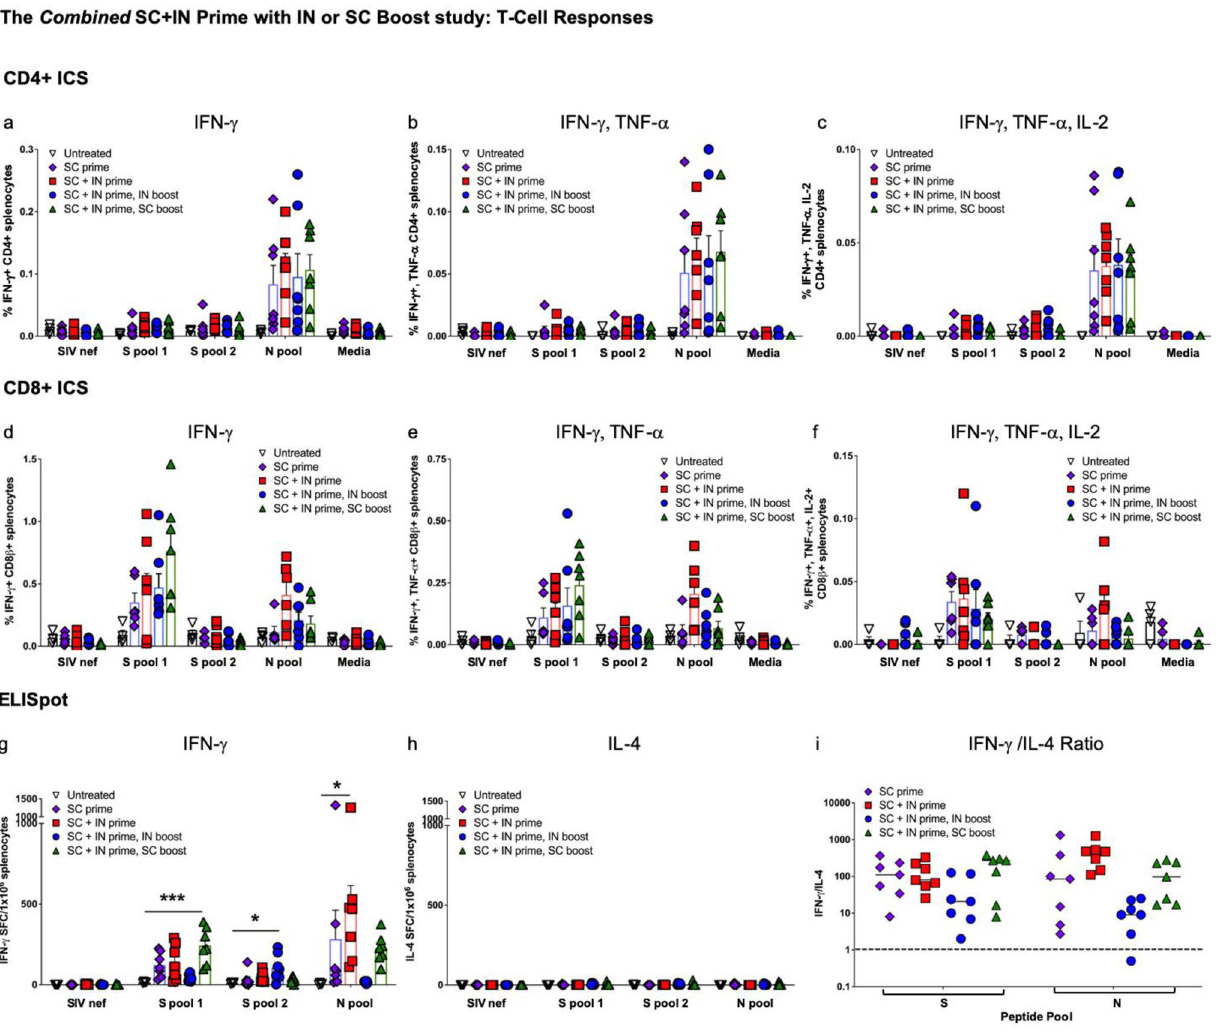
Figure 7. CD4 + T cells respond to nucleocapsid (N) and CD8 + T cells to spike in the combined SC plus IN prime study with SC or IN boost . ICS of IFN-γ; IFN-γ/TNF-α; and IFN-γ/TNF-α/IL-2 in response to S peptide pools 1 and 2 as well as the N peptide pool for CD4 + ( a – c ) and CD8 + ( d – f ) T lymphocytes is shown. Some outliers by the Grubb’s test were removed. SIV nef and media are negative controls. ELISpot for ( g ) IFN-γ and ( h ) interleukin-4 (IL-4) secretion in response to the peptide pools I shown. SIV nef is a negative control. ( i ) The IFN-γ/IL-4 ratios where values > 1 (dashed line) indicate Th1 bias. Statistical analyses performed using One- way ANOVA with Dunnett’s post-hoc comparison of each group to untreated where * p < 0.05, ** p ≤ 0.01, and *** p ≤ 0.001. Untreated n = 4 and all vaccinated groups n = 7 (unless removed as an outlier). Data graphed as the mean with